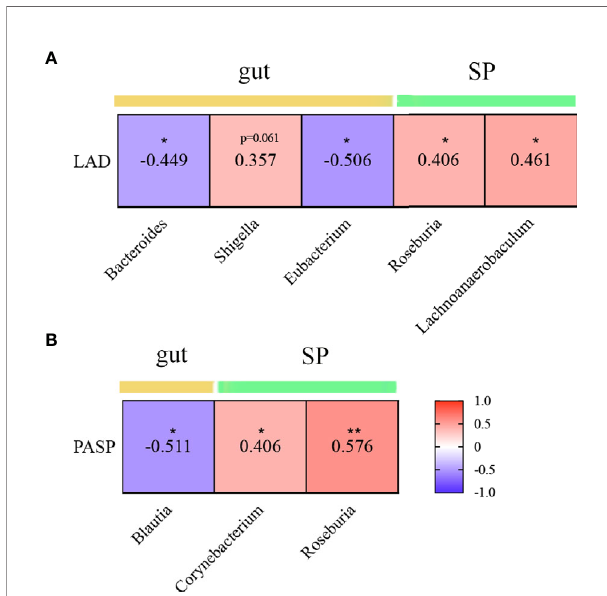
FIGURE 6 | Correlations between microbial genera and clinical indices in patients with rheumatic heart disease. (A) Heatmap showing correlations between different genera and LAD. (B) Heatmap showing correlations between different genera and PASP. LAD indicates left atrial diameter; and PASP, pulmonary artery systolic pressure. SP indicates subgingival plaque. Spearman ’ s rank correlation coef fi cients are illustrated in squares. *P < 0.05; **P <